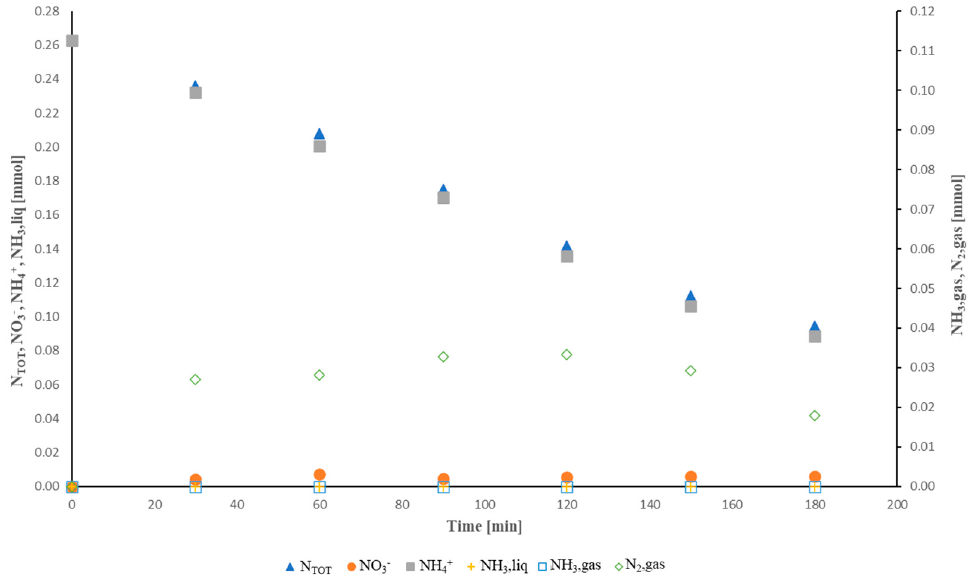
Figure 6. Nitrogen mass balance.